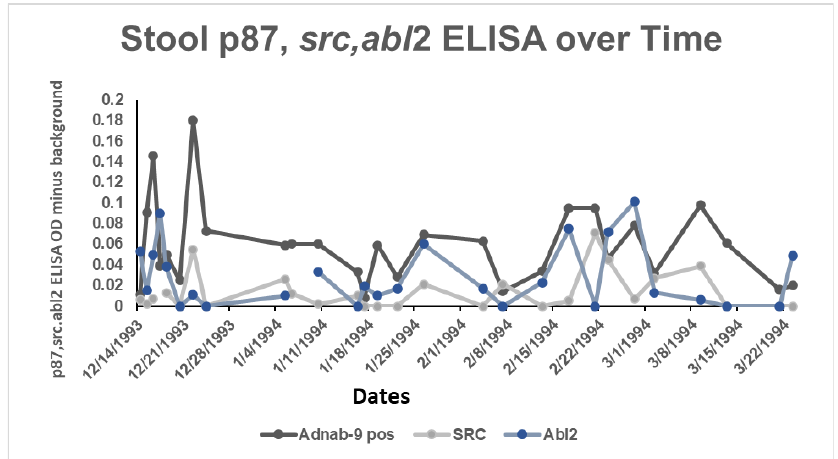
Figure 16. Depiction of 3 biomarkers expressed in the stools of a neonate during the first months of life as determined by ELISA.